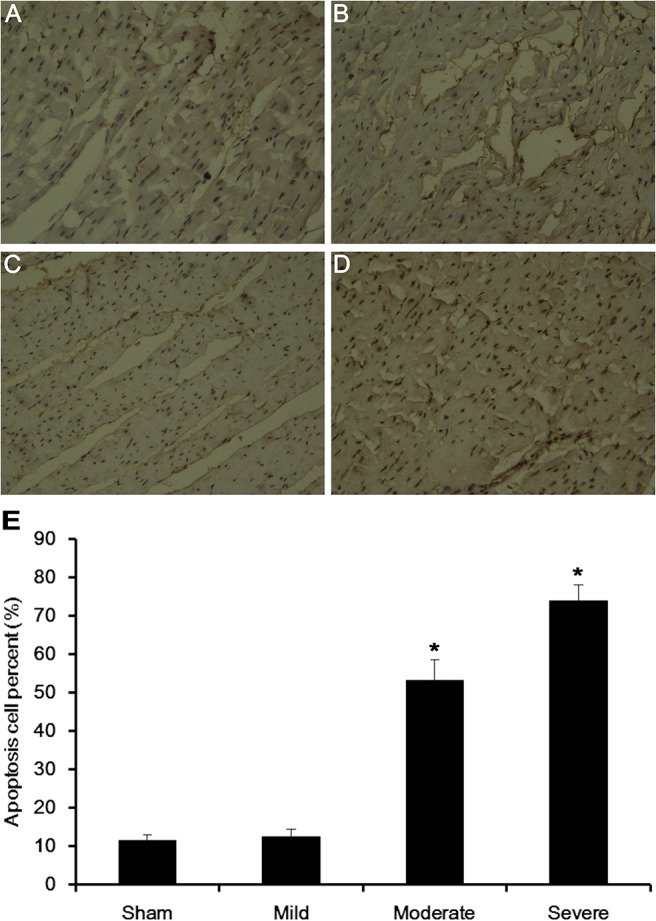
Myocardial cell apoptosis of each group (DAB coloration, ×400).(A) Sham group. (B) Mild stenosis group. (C) Moderate stenosis group. (D) Severe stenosis group. (E) Quantification of cell apoptosis in the four stenosis groups. *P<0.05 vs. the sham operated group.